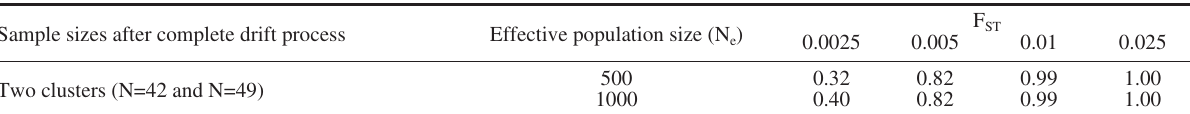
=0.0025, 0.005, 0.01, 0.025) were pre-defined with populations sizes ST